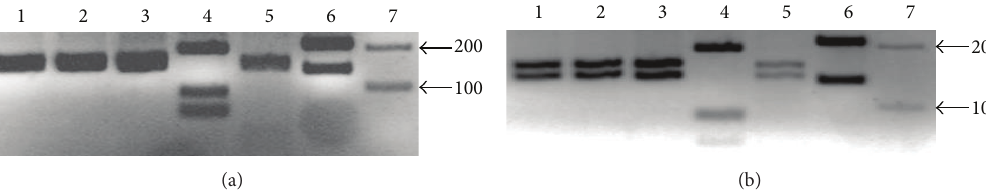
Figure 1: (a) Electrophoresis run at 100V for 30 min. (b) Electrophoresis run at 199V for 60min. PCR-RFLP of the ITS1 of Leishmania reference strains. Lane 1: Leishmania (V.) panamensis MHOM/CR/87/NEL3; lane 2: Leishmania (V.) panamensis MHOM/PA/72/LS9 ; lane 3: Leishmania (V.) guyanensis (MHOM/BR/75/M4147); lane 4: Leishmania (L.) mexicana (MHOM/MX/85/SOLIS); lane 5: Leishmania (V.) braziliensis (MHOM/BR/75/M2903); lane 6: Leishmania (L.) amazonensis (MHOM/BR/73/M2269); lane 7: MWMX174 Hae III. Table 1: ITS1 PCR-RFLP of isolates of Leishmania analyzed in this study.